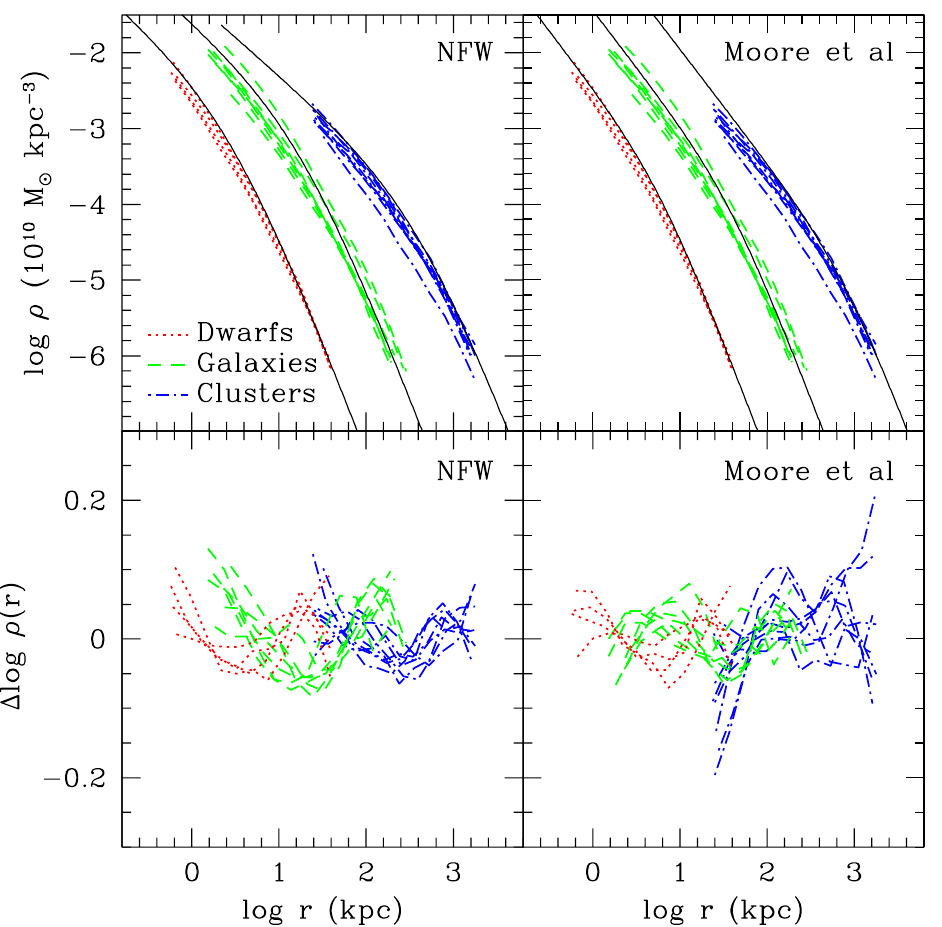
Figure 2. Density profiles comparison. The top left corner is a comparison of the NFW profile (solid line) with Ref. [187]’s simulations, that are well fitted by the Einasto profile [39], in the cases of dwarfs (red line), galaxies (green line), and clusters (blue line). The top right corner is the same as top left, but for the Moore profile. The bottom left and right corners display the residuals (Figure reproduced from